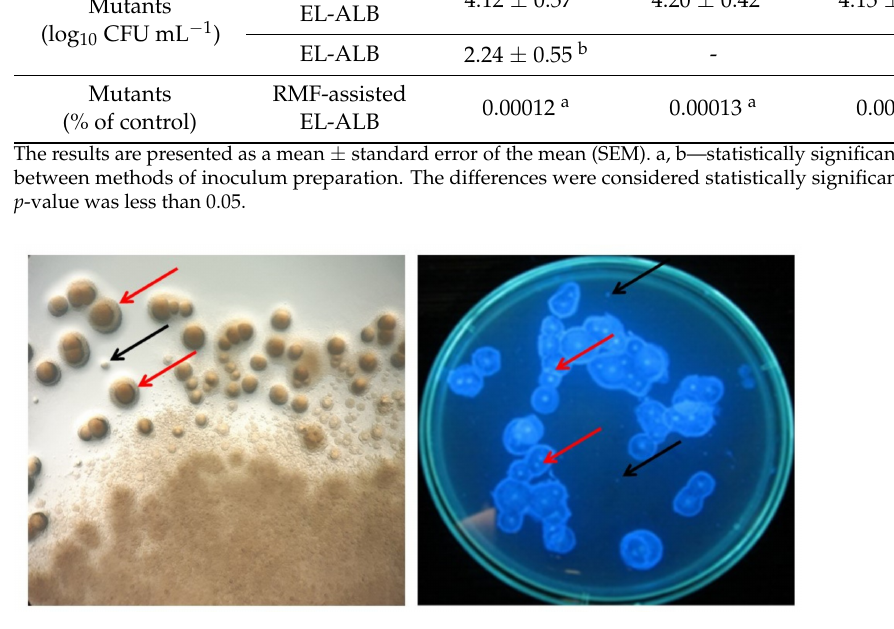
Figure 5. Visualization of cellulose producing bacteria and non-producing mutants. A red ar- row marks the cellulose around the K. xylinus colony. A black arrow marks the colony of non- producing